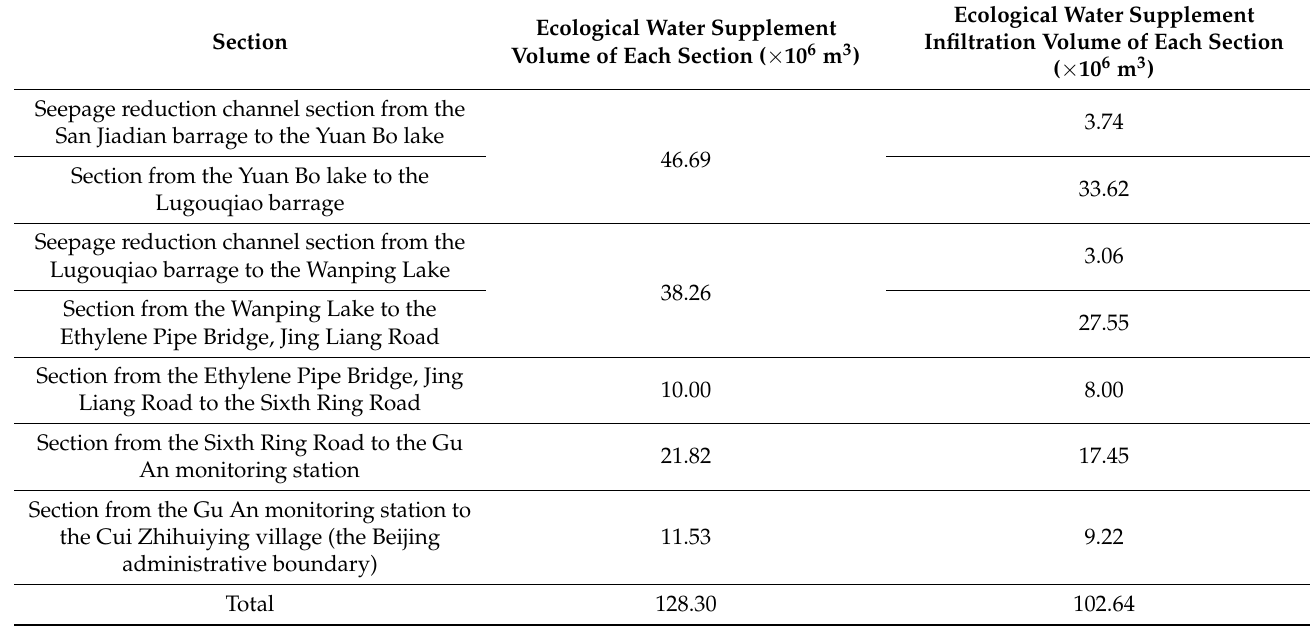
Table 4. Ecological water supplement infiltration volume for each section of Yongding River in 2020.